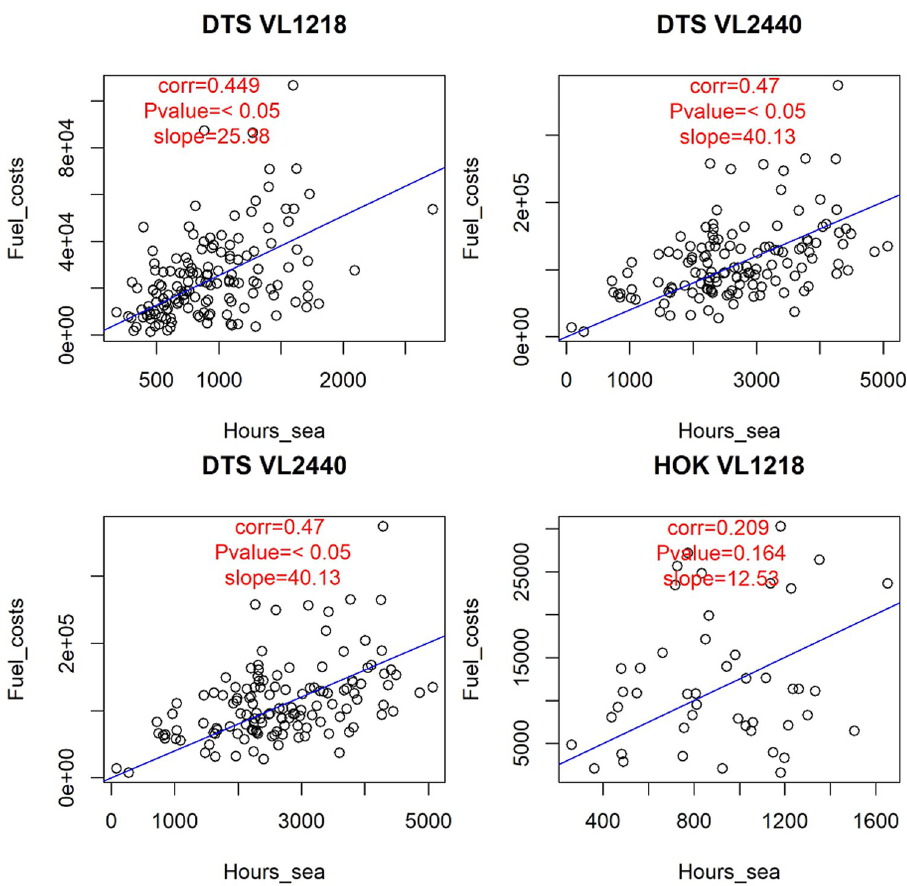
Fig 3. Linear correlations between fuel costs and hours at sea for the analyzed fleet